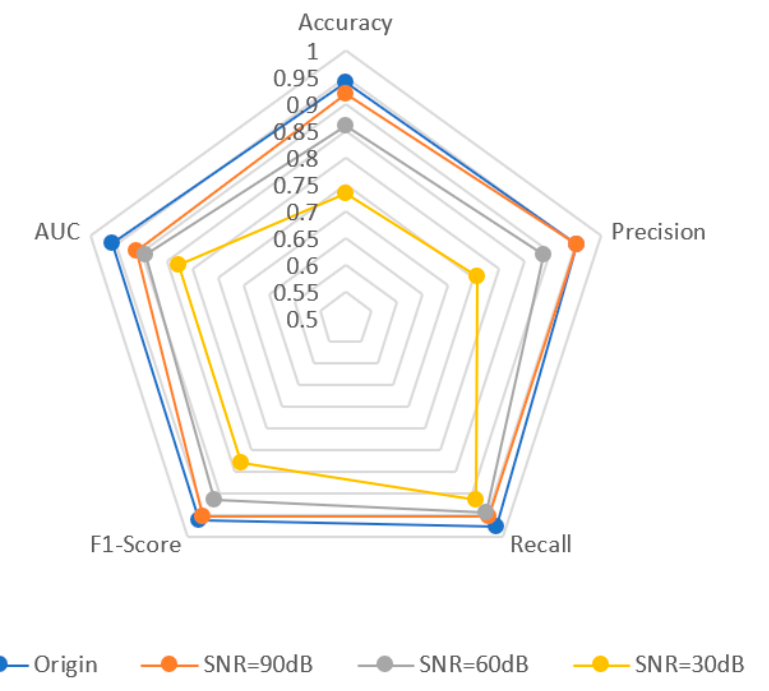
Figure 13. Evaluation of anomaly detection results under different signal-to-noise ratios.